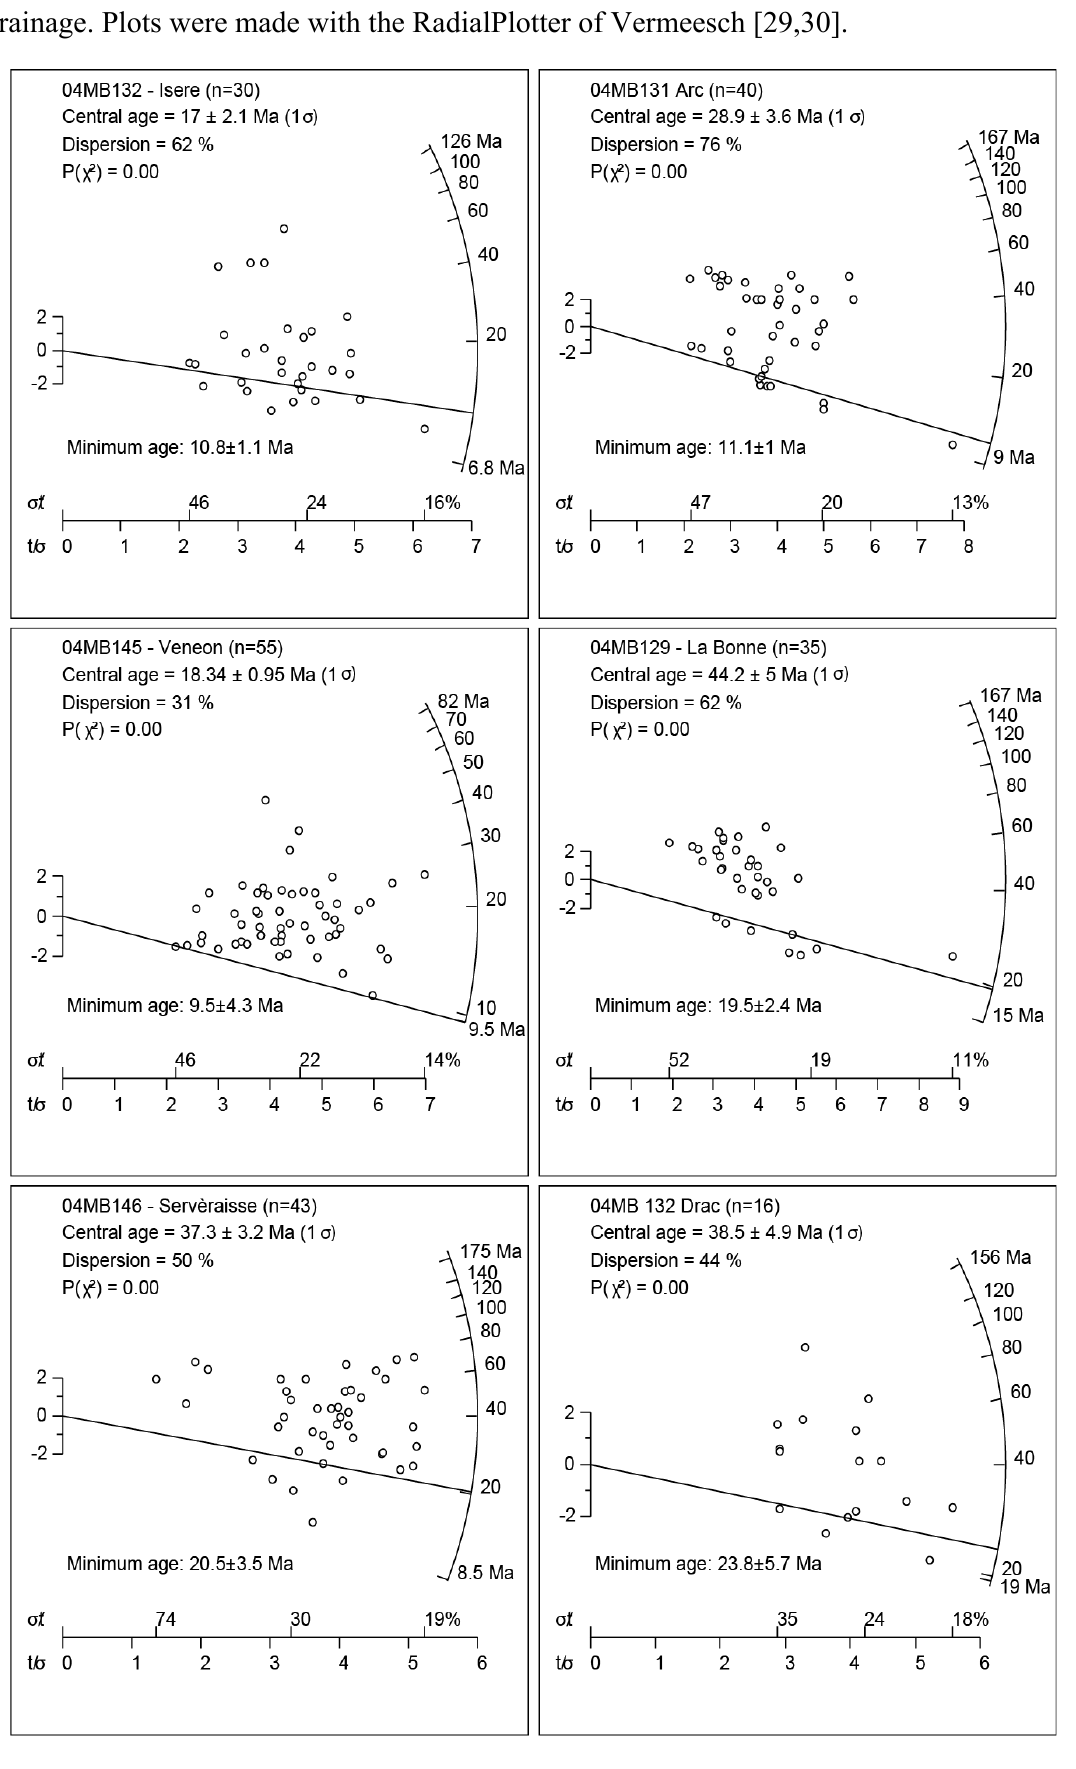
Figure 5. Radial plots of zircon fission-track (ZFT) data of all six samples of the Isère drainage. Plots were made with the RadialPlotter of Vermeesch